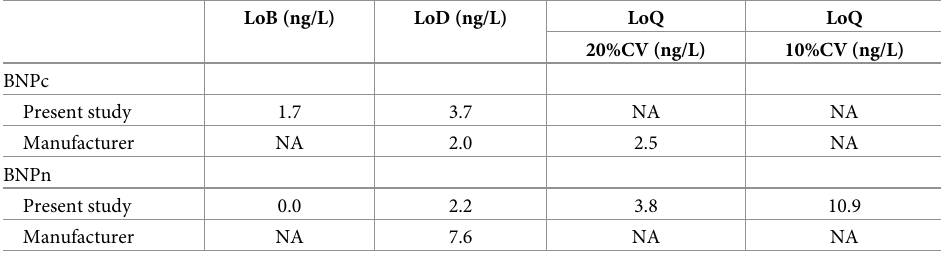
BNPc, brain natriuretic peptide concentration by conventional method; BNPn, brain natriuretic peptide concentration by novel method; CV, coefficient of variation; LoB, limit of blank; LoD, limit of detection; LoQ, limit of quantification, NA; not available.